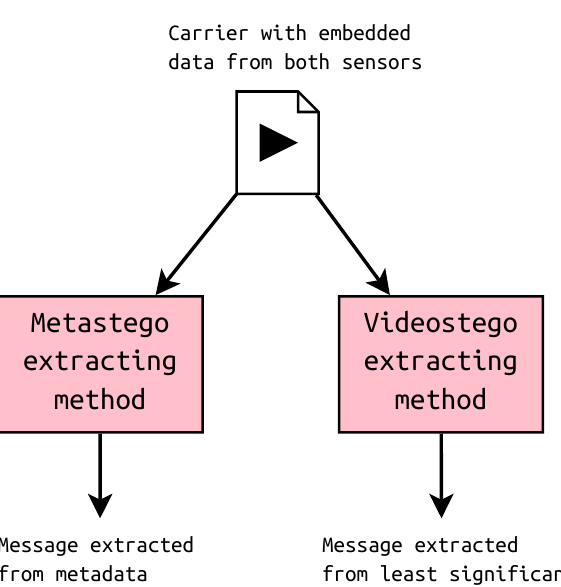
Figure 8. Extracting the hidden messages.